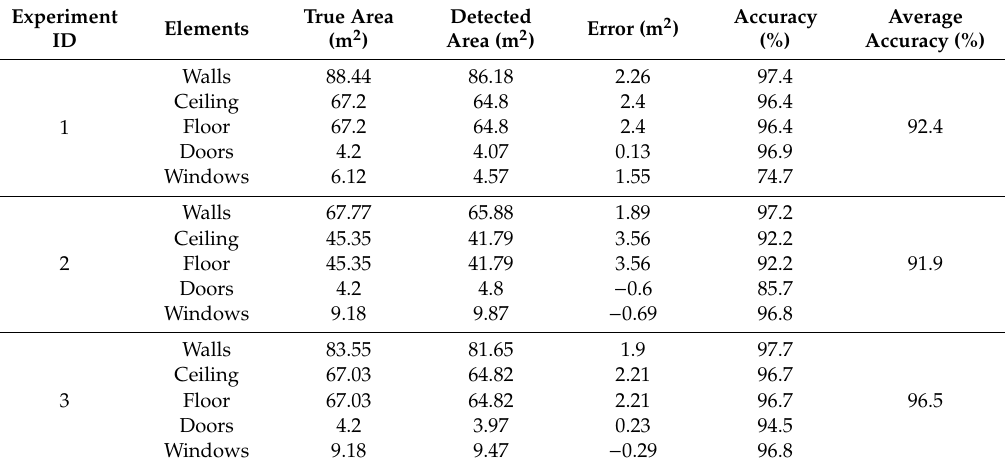
Table 4. Quantitative analysis of measured element areas.